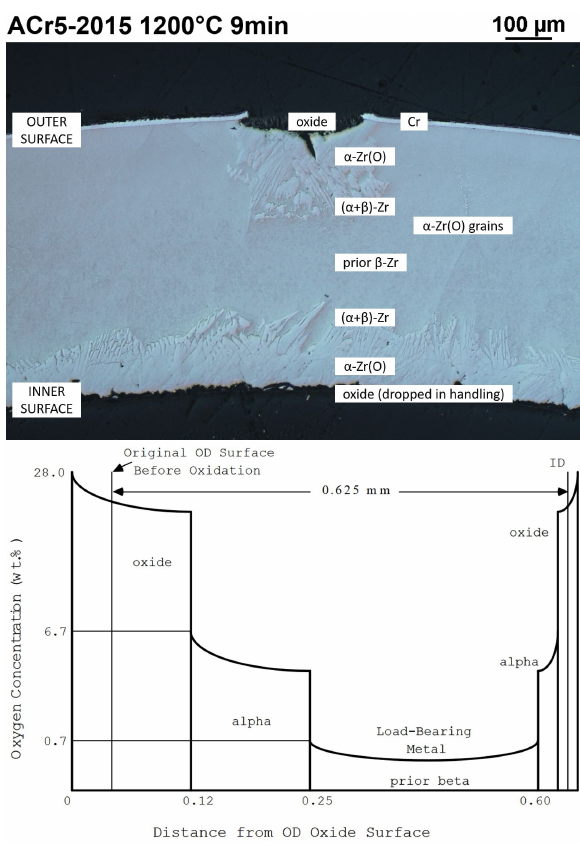
Figure 6. Typical misrostructure of high-temperature oxidized Zr-based cladding: with Nb (top) and without Nb (bottom).